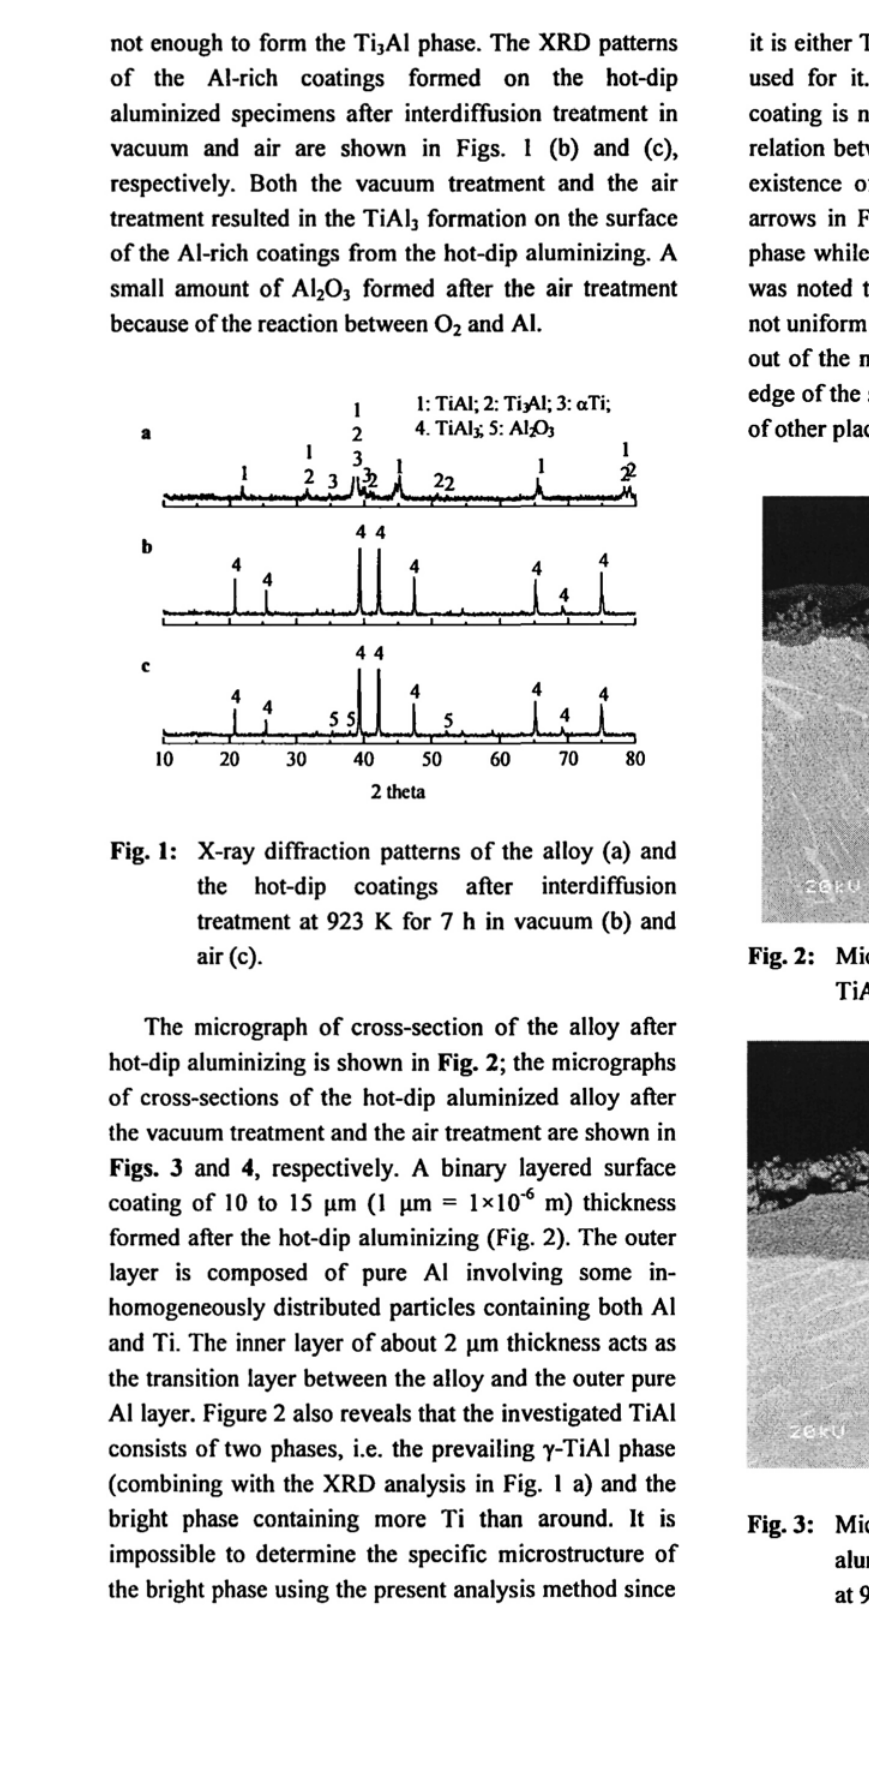
Fig. 3: Micrograph of cross-section of the hot-dip aluminized alloy after interdiffusion treatment at 923 Κ for 7 h in